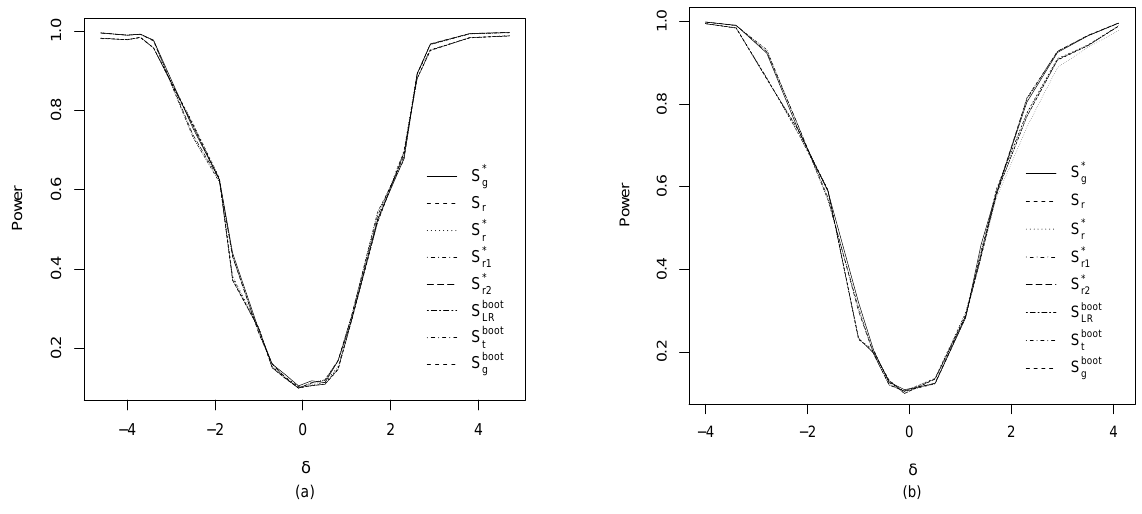
∶ 𝛿 = … = 𝛿 = 𝛿 with p = 3 , n = 30 , 𝛼 = 10 %; ( a ) t 0 1 3